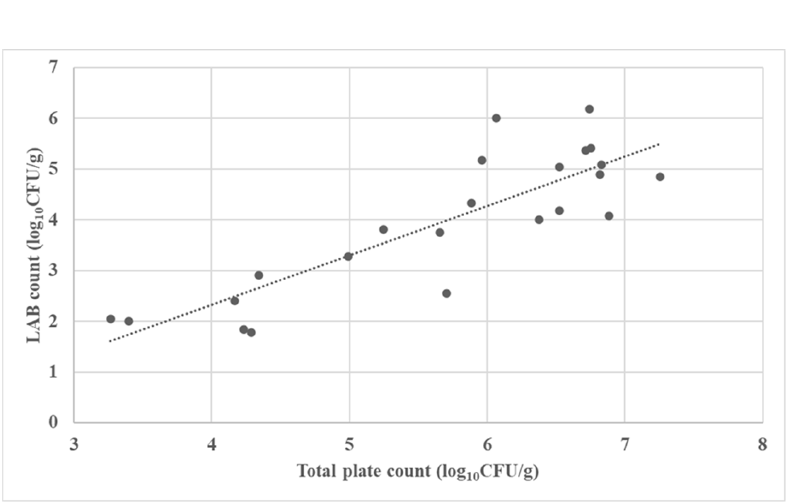
Figure 1. Correlation of total plate count and LAB counts in the final stage of the fermented forages.